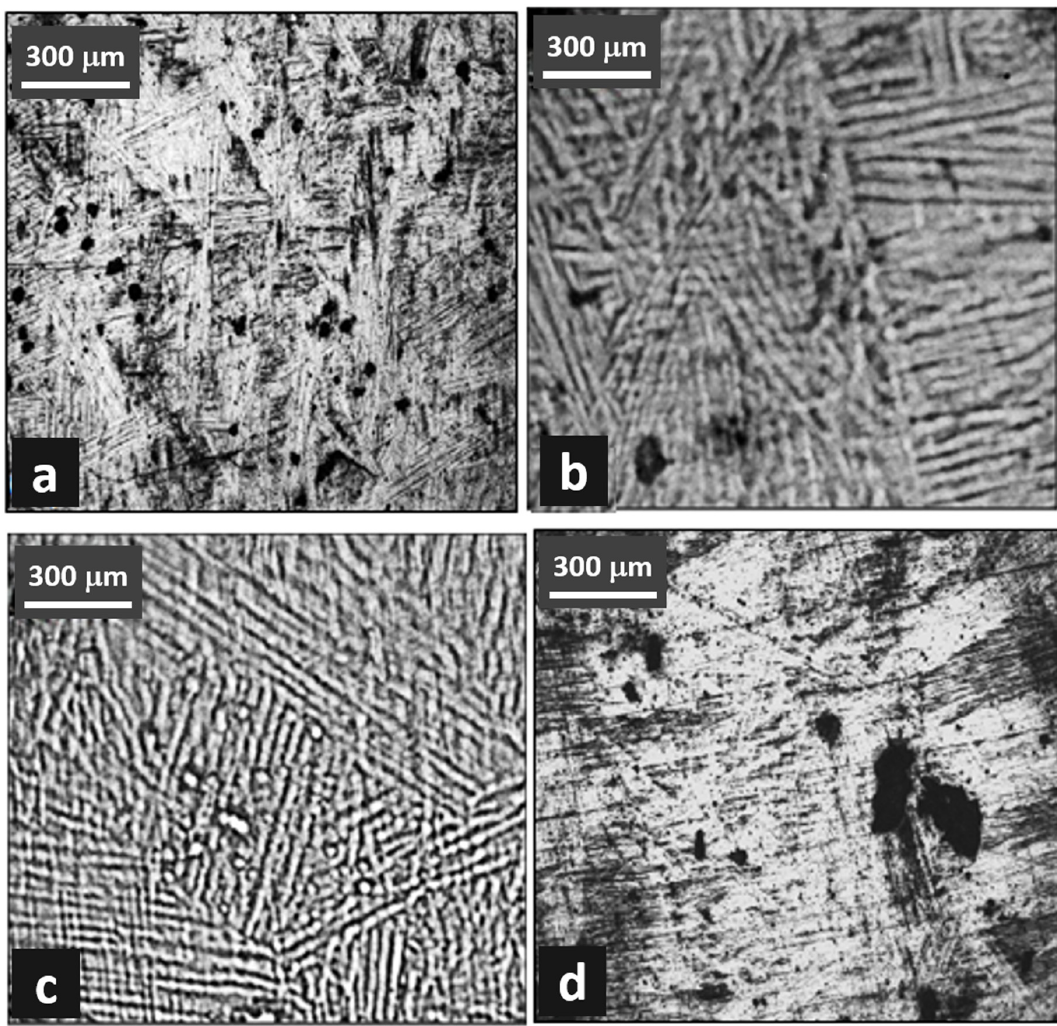
Figure 1. Microstructure of Ti-6Al-4V alloy. ( a ), ( b ) water quenched, and ( c ), ( d ) air cooled.